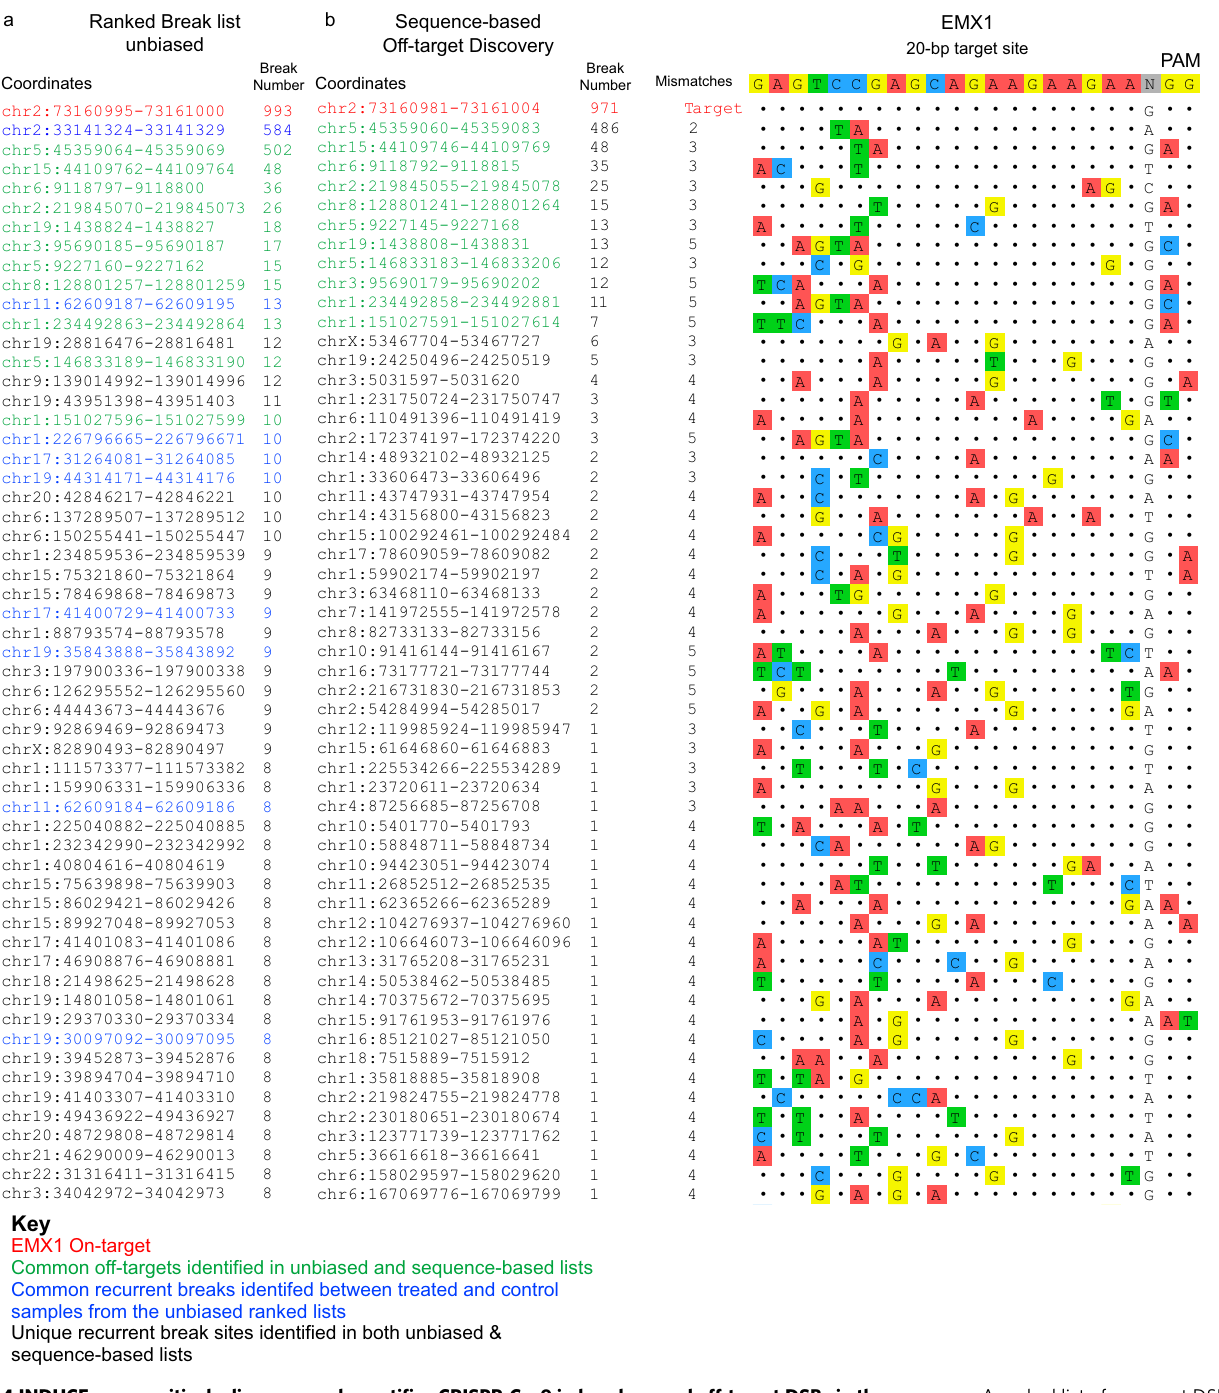
NATURE COMMUNICATIONS| (2022) 13:3989